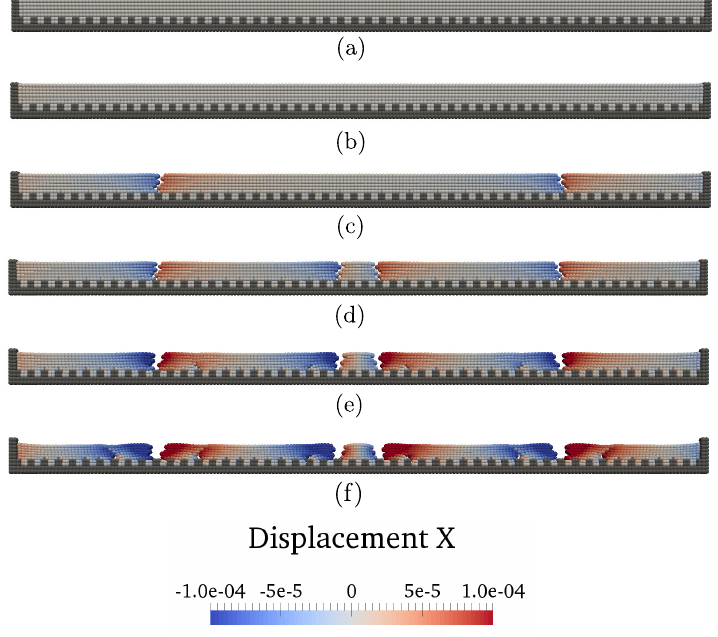
Figure 4. Snapshots of contours of displacement superimposed on the deformed configuration at 6 load steps: ( a ) Step 1; ( b ) Step 50; ( c ) Step 90; ( d ) Step 100; ( e ) Step 180; ( f ) Step 250. Note: The deformation is amplified by a factor of 15 to highlight the formation of